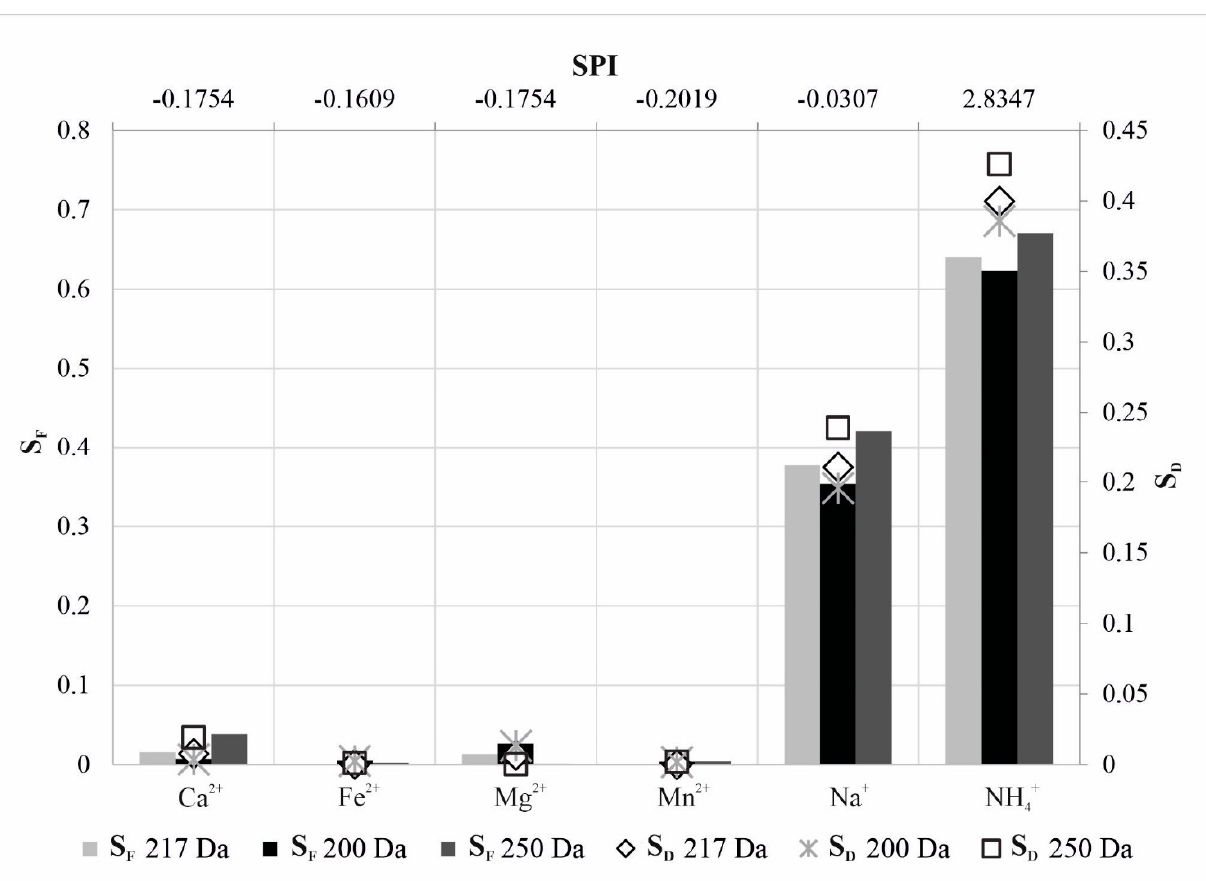
Figure 6. Correlation of steric hindrance factors and solute permeation indicator for investigated cations.